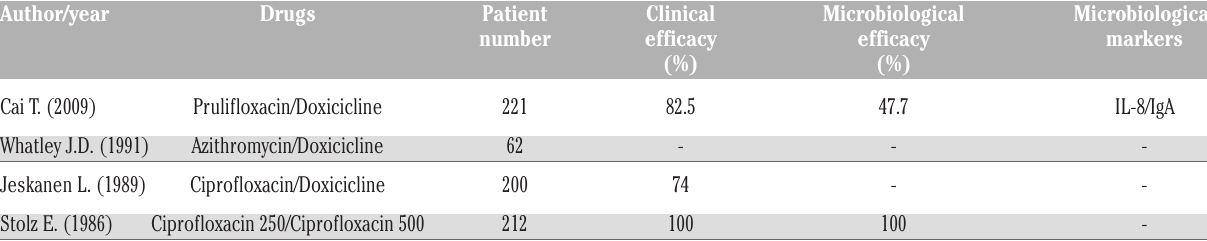
Table 1. Randomized, controlled, clinical